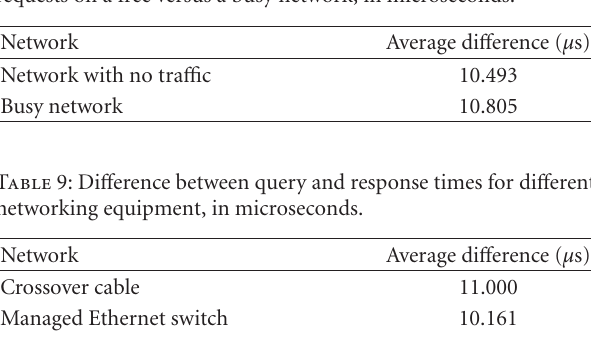
Table 8: Di ff erence between query and response times for NTP requests on a free versus a busy network, in microseconds.